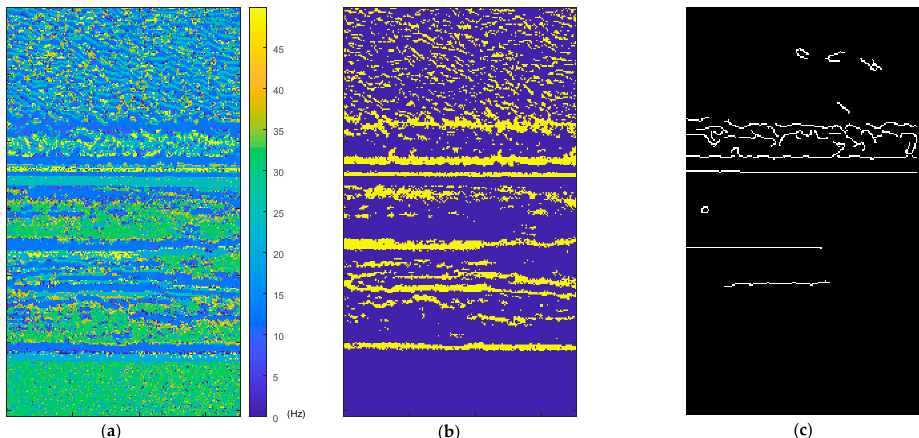
Figure 11. Laboratory experimental result visualization using the proposed method: ( a ) Prediction result map; ( b ) Pixels predicted at 12.4 Hz (maximum value of histogram) highlighted; ( c ) Pixels used in edge enhancement.